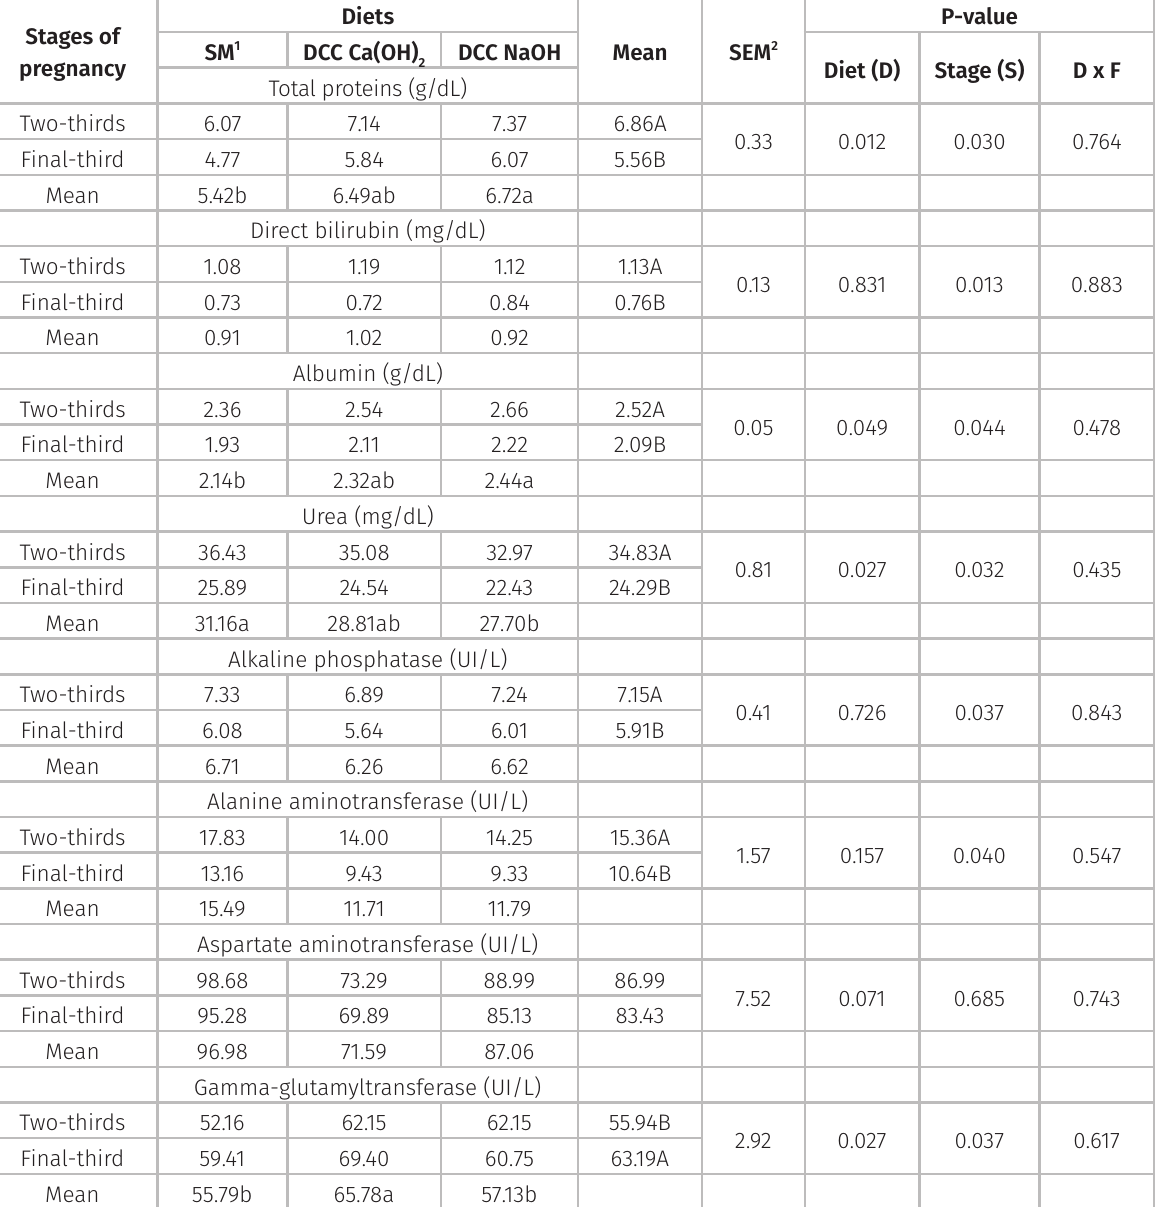
Table VII. Blood Parameters of goats fed with detoxified castor cake (DCC) at different stages of pregnancy. Diets Stages of pregnancy